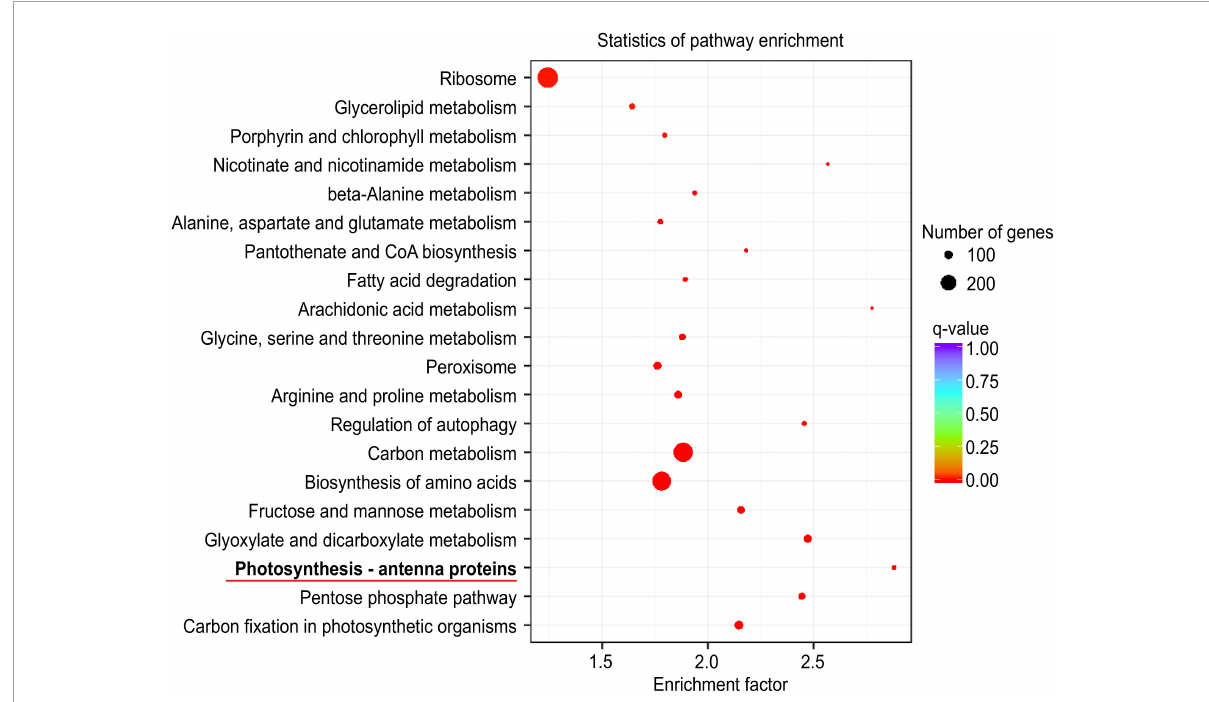
FIGURE4 KEGG pathway enrichment analysis results between CN19 and CN17 at 40 DAH. Each circle in the figure represents a KEGG pathway. The vertical coordinate represents the name of the pathway, and the horizontal coordinate represents the enrichment factor. The larger the enrichment factor is, the more significant the enrichment level of DEGs in that pathway. The color of the circle represents the q value, which is the P value according to multiple hypothesis test corrections. The smaller the q value is, the more reliable the enrichment significance of the DEGs in that pathway. The size of the circle represents the number of genes enriched in the pathway. The larger the circle is, the more genes that are in that